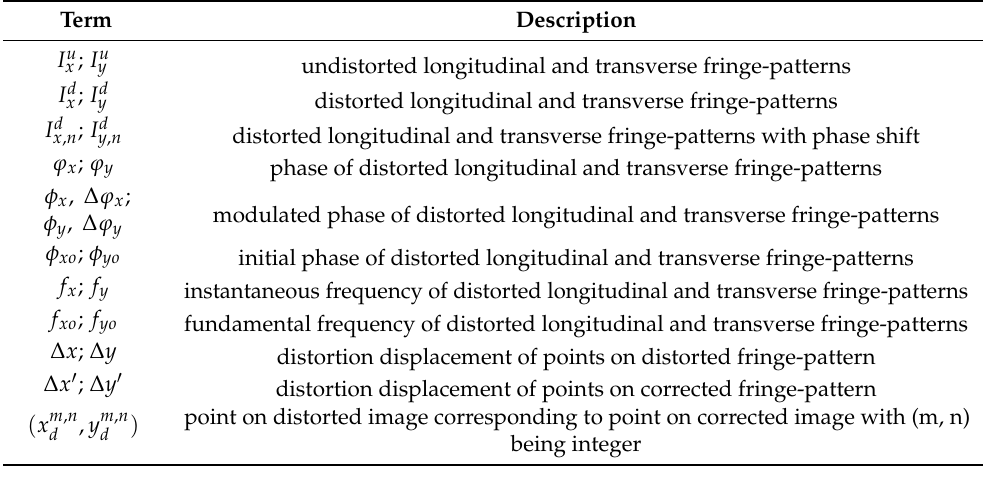
Figure 1. Distortion schematic diagram for the negative (barrel) distortion, where the blue and red lines are corresponding to the fringe-pattern stripes before and after distortion, respectively. Table 1. Nomenclature.